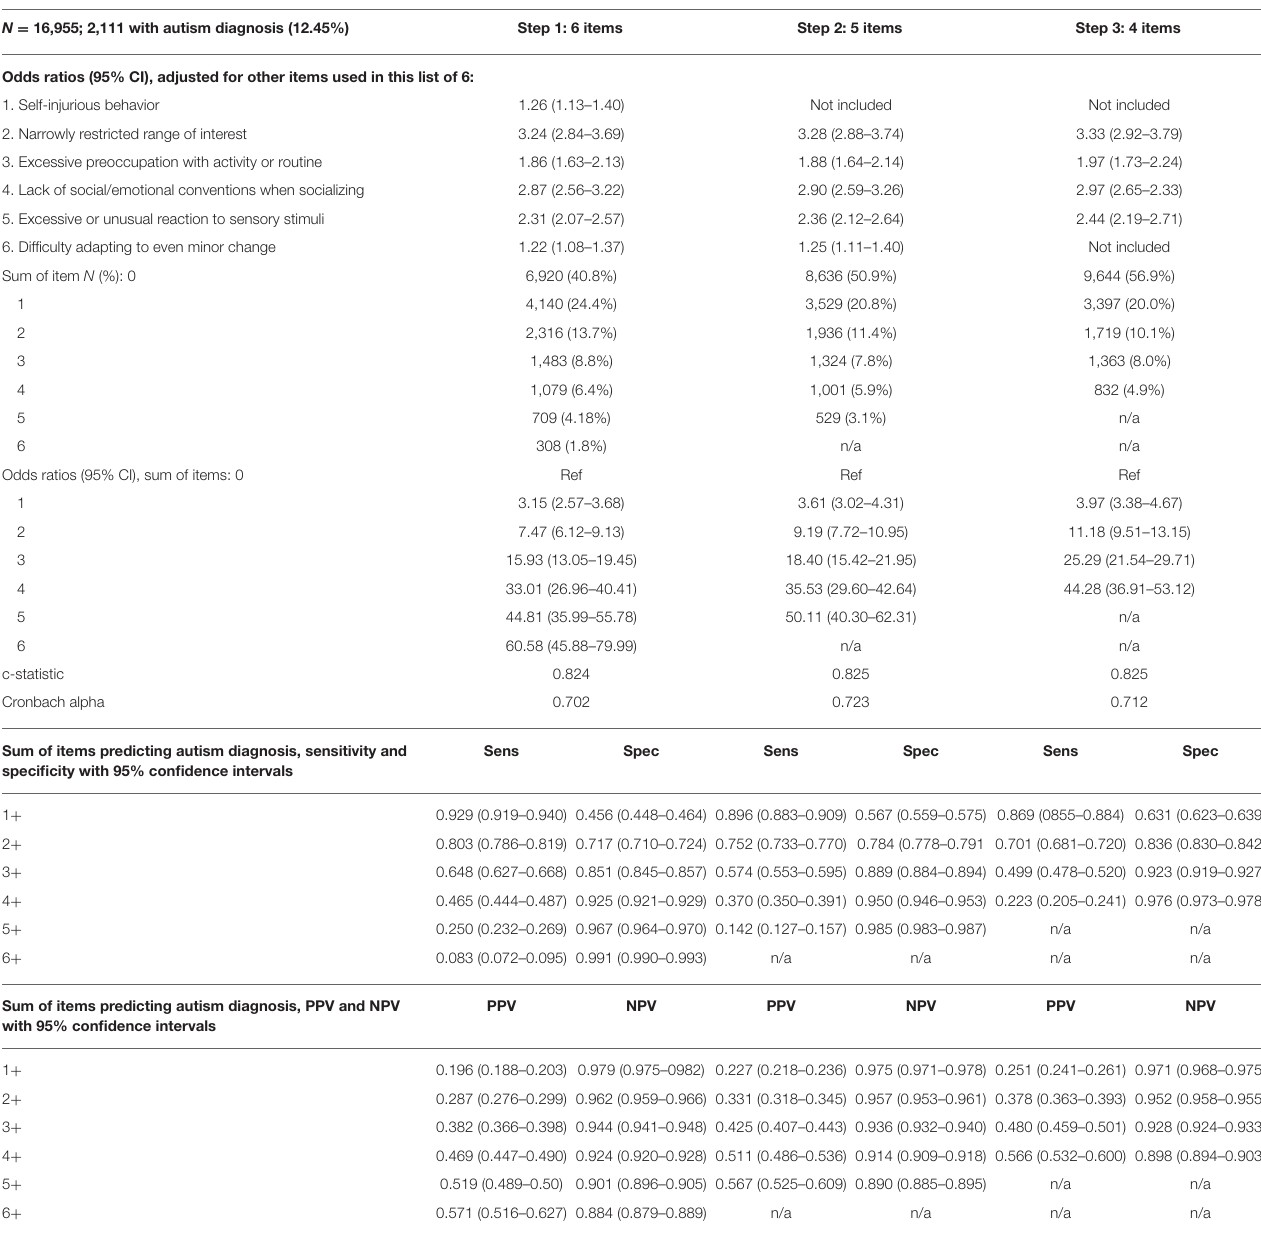
TABLE 2 | Sequential steps and results: Derivation sample. N = 16,955; 2,111 with autism diagnosis